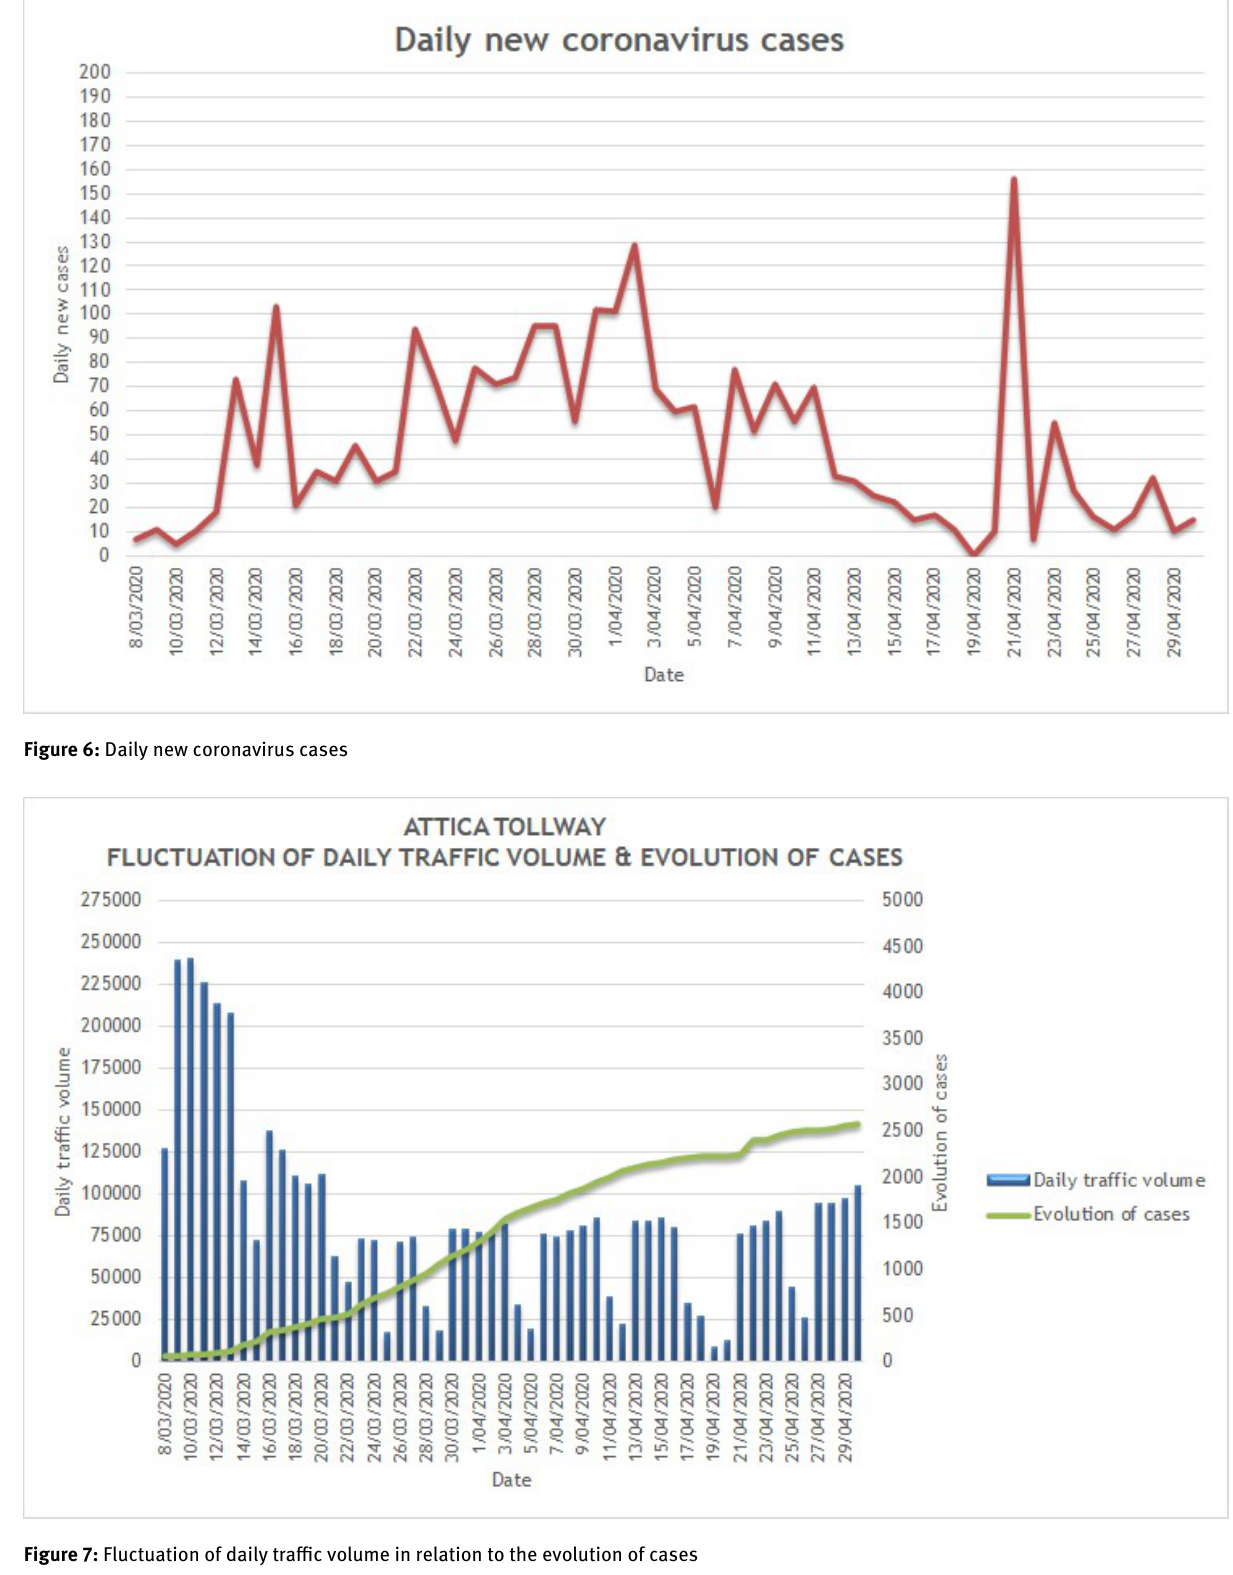
Figure 7: Fluctuation of daily traflc volume in relation to the evolution of